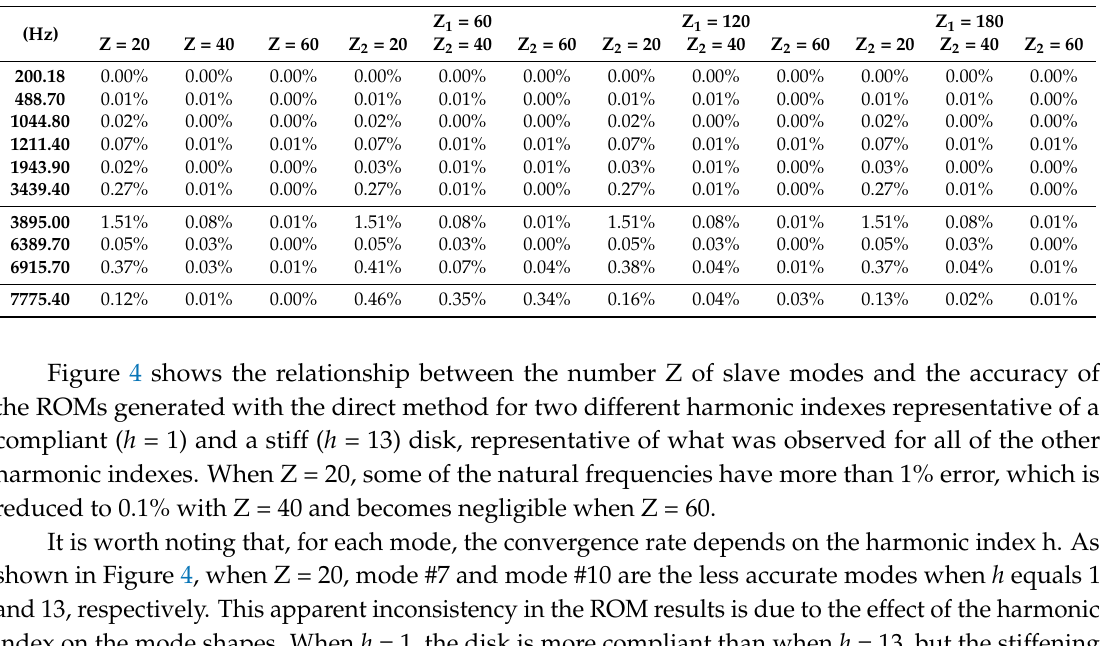
Table 3. Test Case A (linear elements, h = 1)—relative error between natural frequencies.